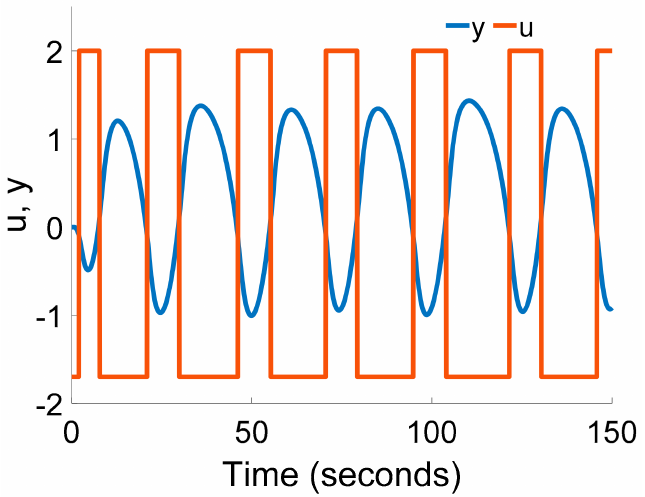
Figure 20. The relay output u and the observed output y of the process P 5 ( s